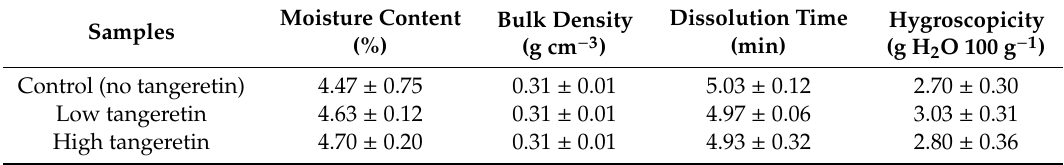
Table 1. Physical properties of tangeretin in citrus pectin and sodium alginate matrix microcapsules.